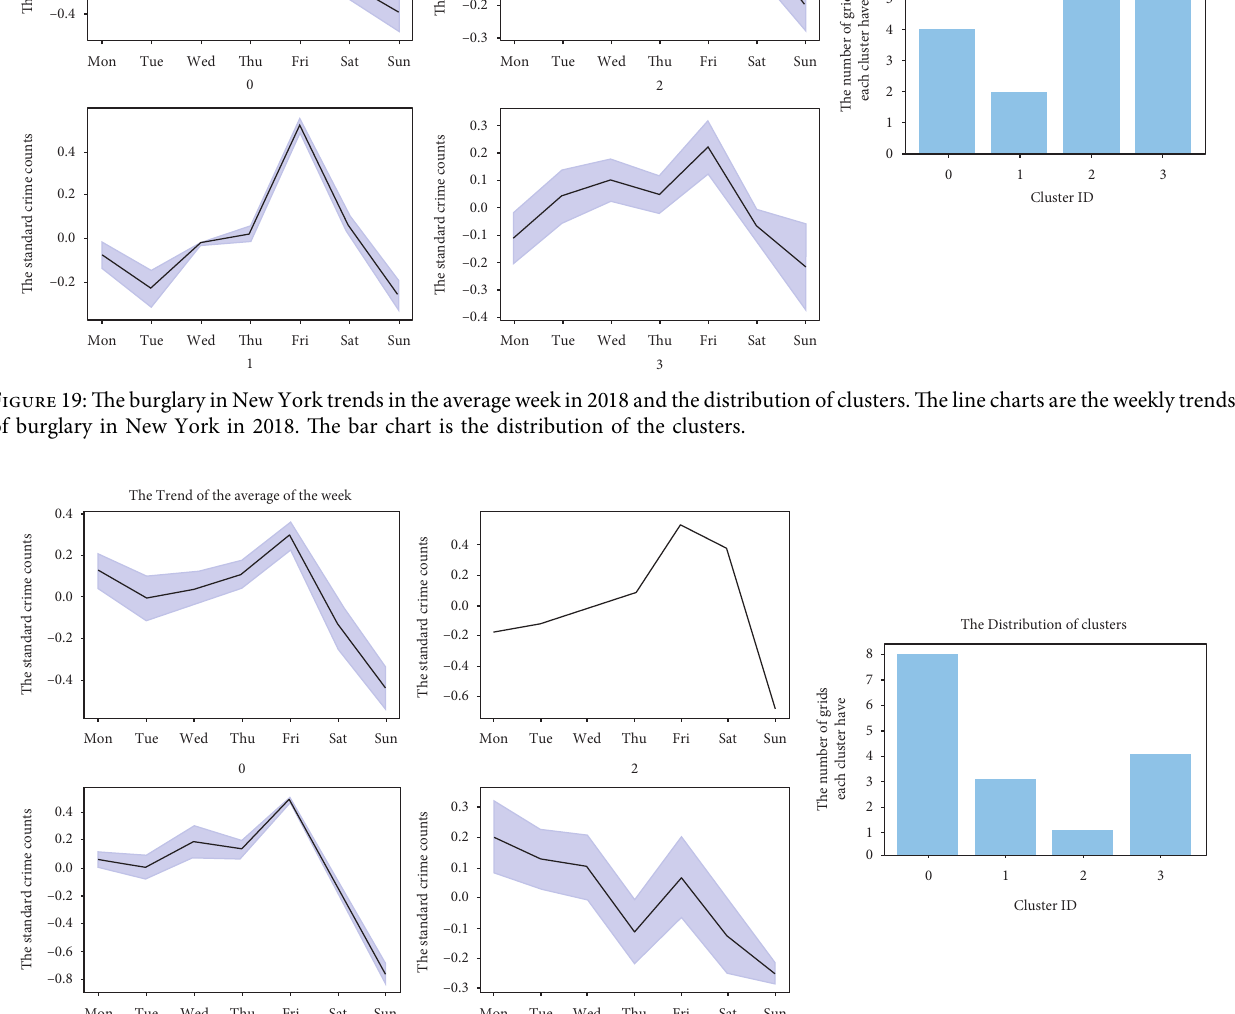
Figure 20: The theft in New York trends in the average week in 2018 and the distribution of clusters. The line charts are the weekly trends of theft in New York in 2018. The bar chart is the distribution of the